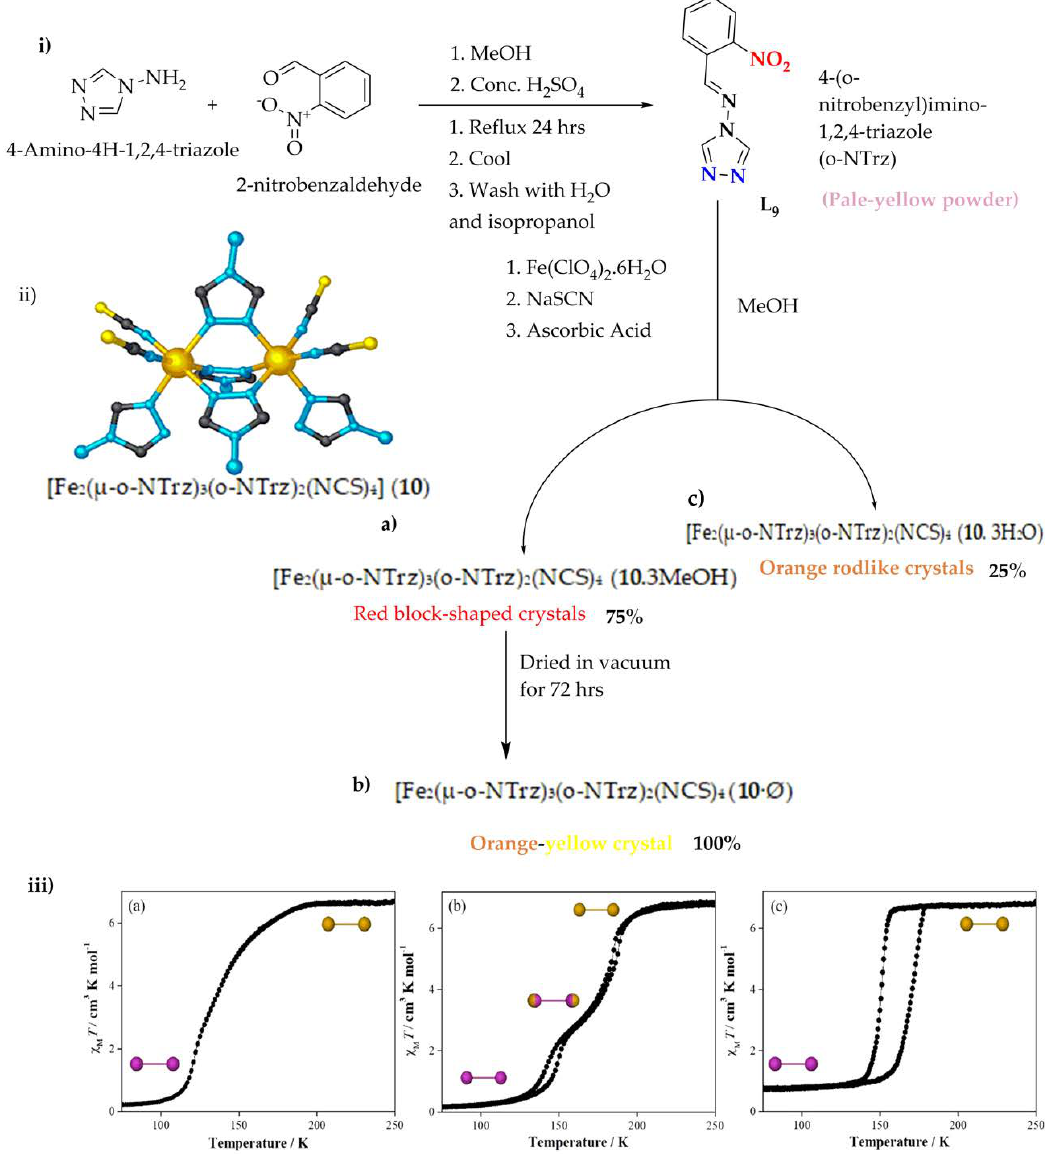
Figure 9. ( i ) o -NTrz, 4-(onitrobenzyl)imino-1,2,4-triazole (blue: N-Fe binding groups, red: function- ality). ( ii ) Di-nuclear [Fe 2 ( µ - o -NTrz) 3 ( o -NTrz) 2 (NCS) 4 ] ( 10 ) core structure ( a ) 10 · 3MeOH, ( b ) 10 · Ø, and ( c ) 10 · 3H 2 O ( iii ) χ M T vs. T plot of the three complexes ( a ) 10 · 3MeOH, ( b ) 10 · Ø, and ( c ) 10 · 3H 2 O (250 − 50 − 250 K; sweep mode; scan rate: 2 K min − 1 ). Inset: Spin-state per di-nuclear unit at the indi- cated plateau region, as determined by structural analysis (Fe-Fe; HS: gold; LS: purple). Reproduced with permission from [82]; Published by American Chemical Society,